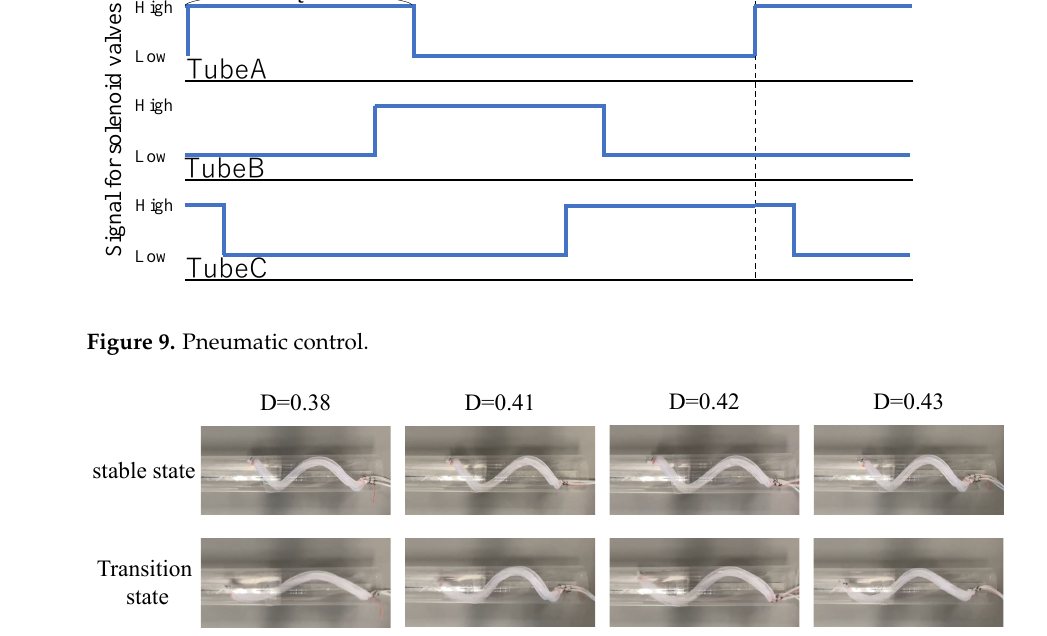
Figure 10. Experiments in which the device was driven within a period of 1000 ms and at an air pressure of 0.14 MPa with different duty